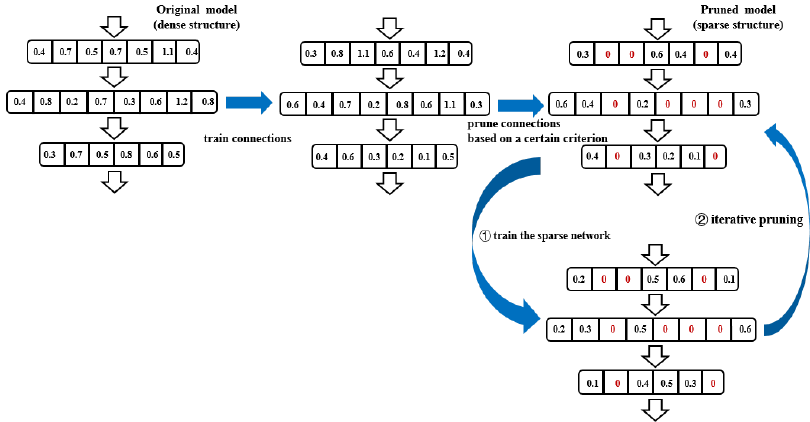
Figure 7. Flow chart of the iterative pruning